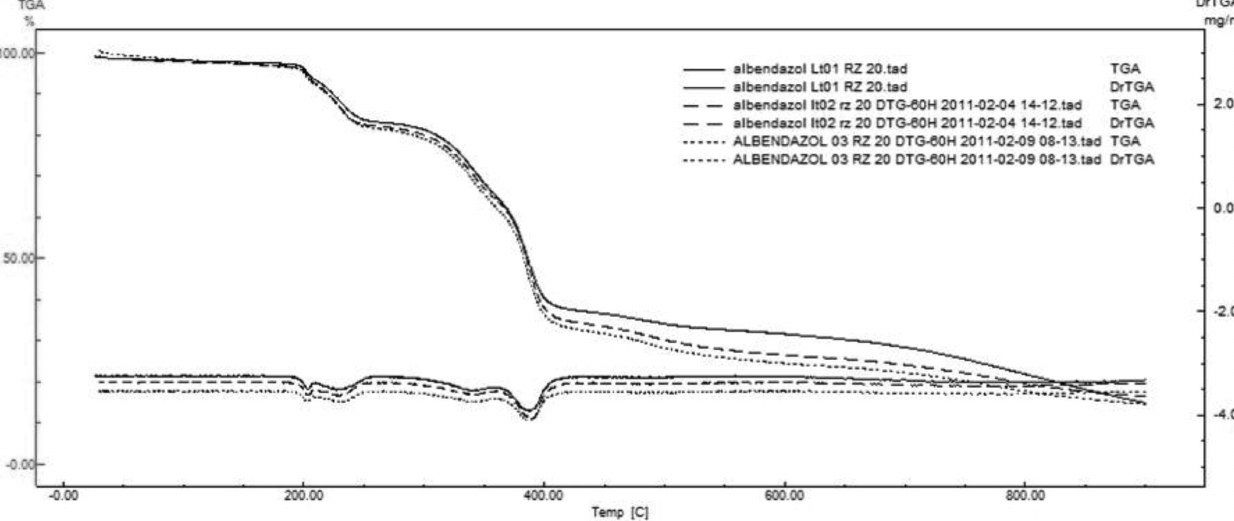
FIGURE 8 - Thermal profile of the 3 batches, ABZ01, ABZ02, and ABZ03, based on TG/DTG